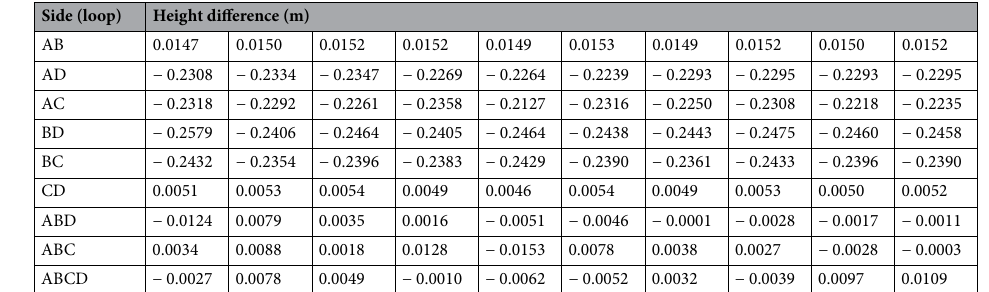
Table 3. Height difference in partly different groups of observation side and closed loop.